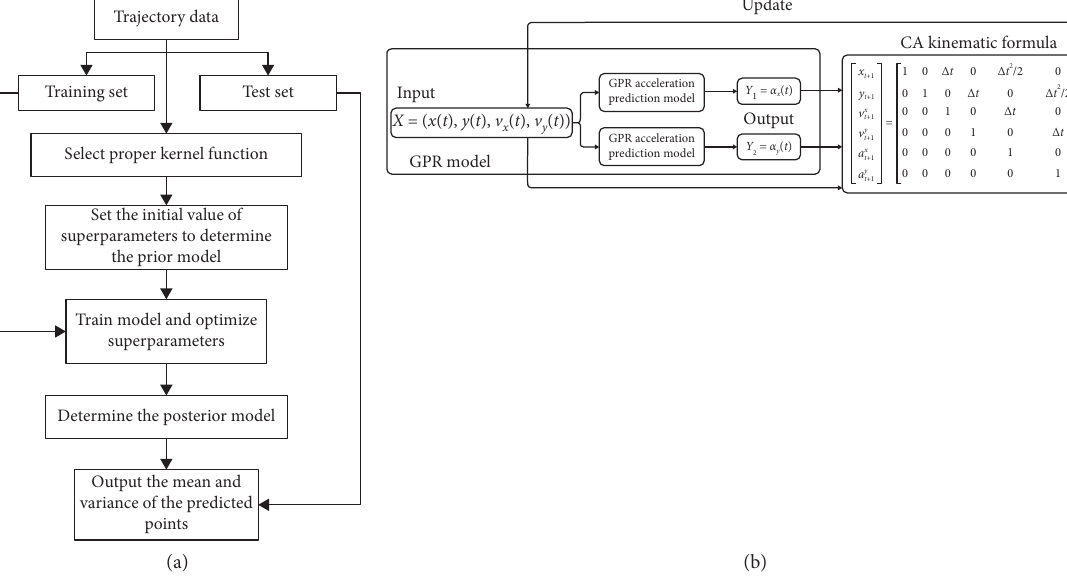
Figure 4: (a) The training process of the GPR model. (b) The trajectory prediction model.